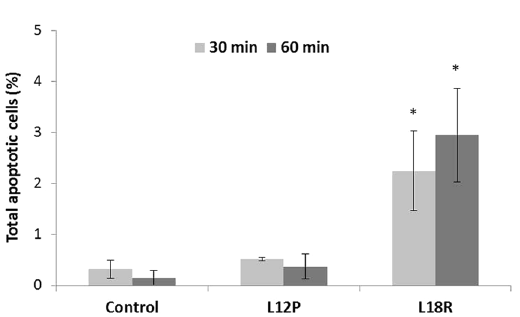
Figure 2. Apoptotic effects of the L12P and L18R peptides on Candida albicans SC5314 cells. Phosphatidylserine externalisation was analysed by flow cytometry after 30 and 60 min of treatment with peptides at 2 × EC 50 . While no difference was observed between untreated cells (control) and cells treated with L12P, after treatment with L18R a significant, although low, percentage of apoptotic cells was observed. Data represent the means ± standard deviations from two independent experiments ( * p < 0.05 vs control untreated